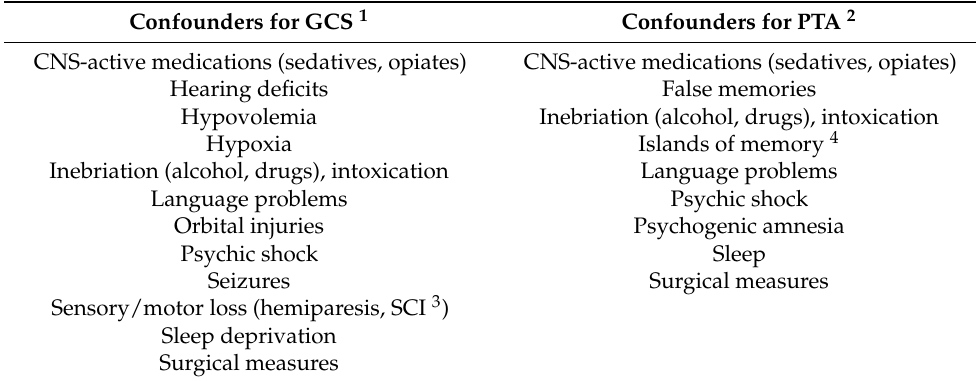
Table 2. Confounders of assessing TBI severity (in alphabetical